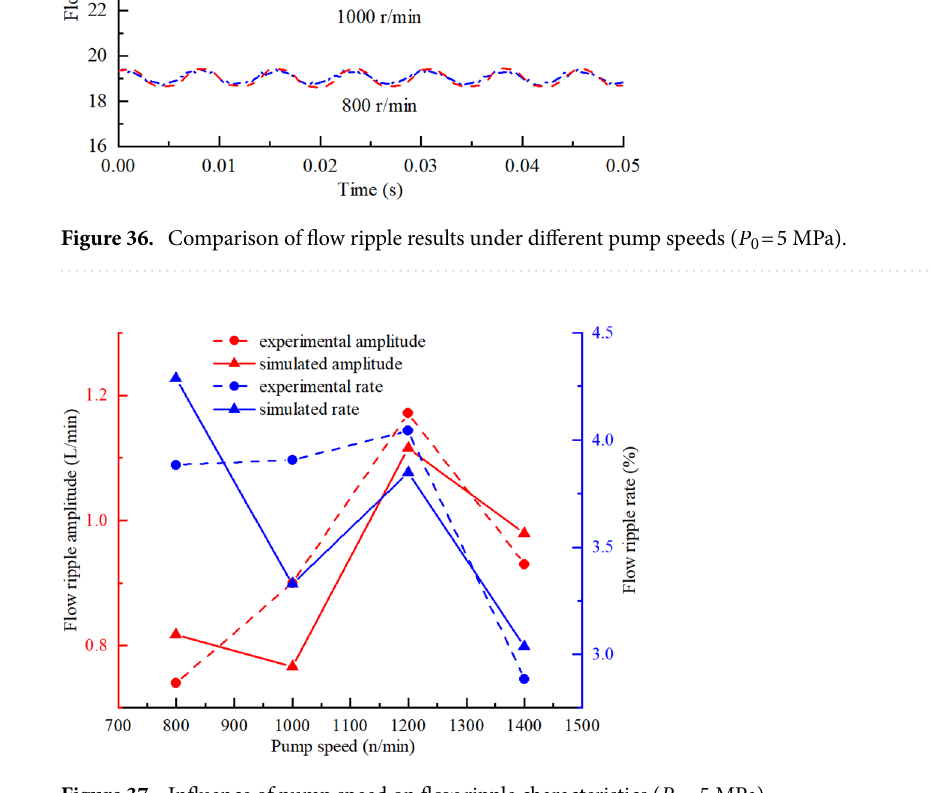
Figure 37. Influence of pump speed on flow ripple characteristics ( P 0 = 5 MPa).